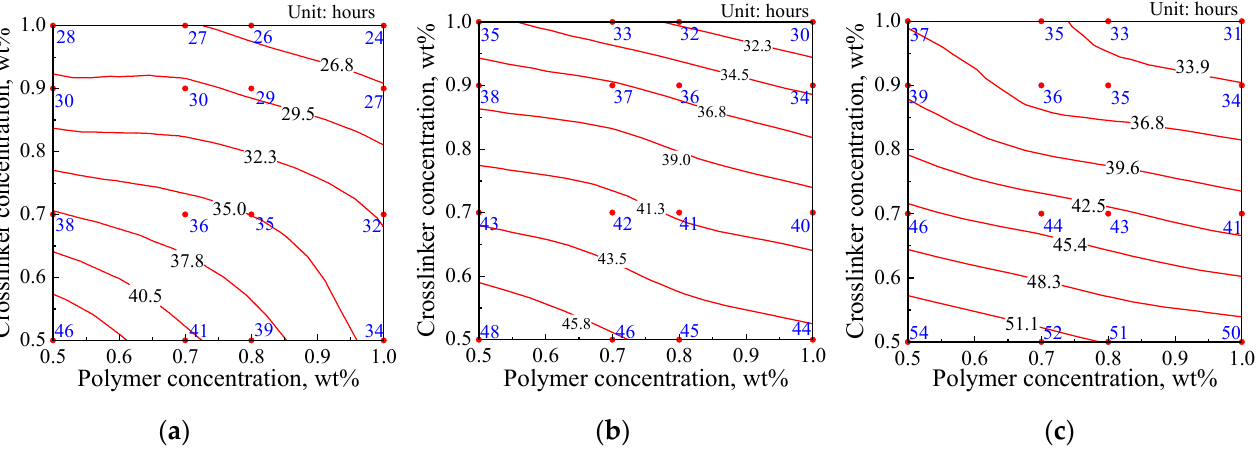
Figure 1. Gelation time of gels prepared with different polymers as a function of the polymer and crosslinker concentrations: ( a ) Isogram of gelation time for G3515; ( b ) Isogram of gelation time for AM-AMPS25; ( c ) Isogram of gelation time for AM-AMPS60.